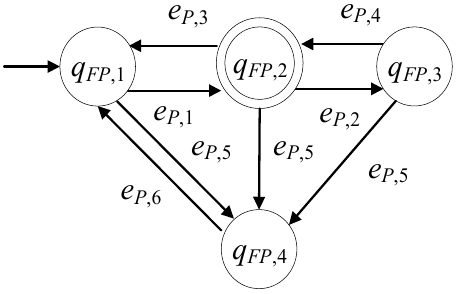
Figure 4. The state diagram of the pressure sensor including faults.